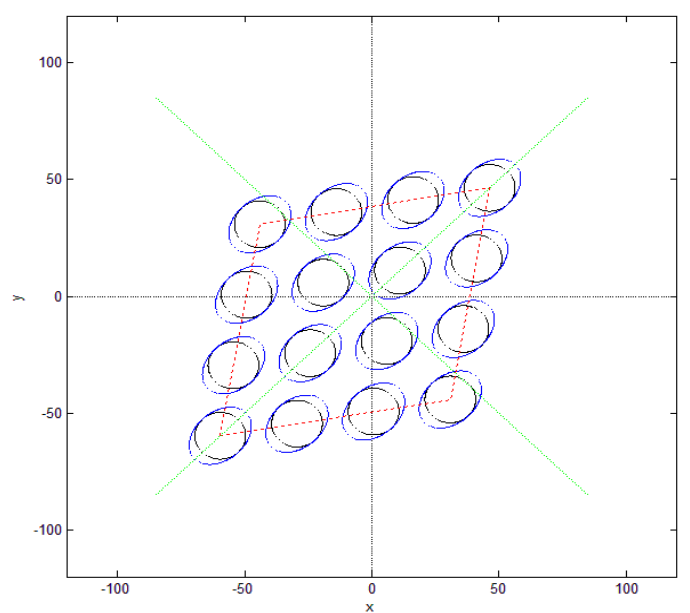
Figure 15. Numerical simulation results of array microstructural forming angle ϕ = 45 ◦ , θ = 45 ◦ .